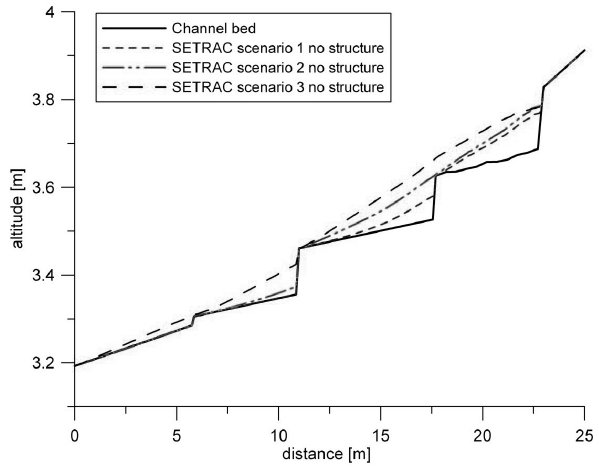
Fig. 8. SETRAC model simulation results for the whole deposition area (distance 6m–23m) for Scenario 1, 2, and 3 – without struc-